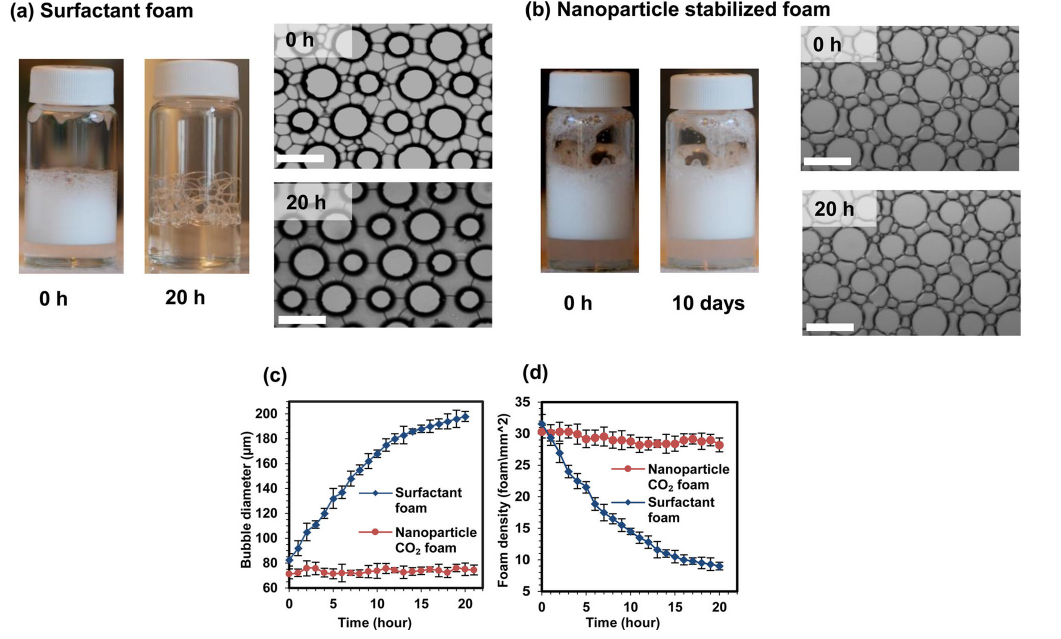
Figure 18. Foam stability results in ( a ) SDS surfactant; ( b ) nanoparticle-stabilized CO 2 foam; ( c ) foam coalescence as a function of the bubble diameter; and ( d ) foam quality represented as a function of the bubble density (bubbles/mm 2 ) (scale bars = 400 µ m). Figure reproduced from Ref. [104].